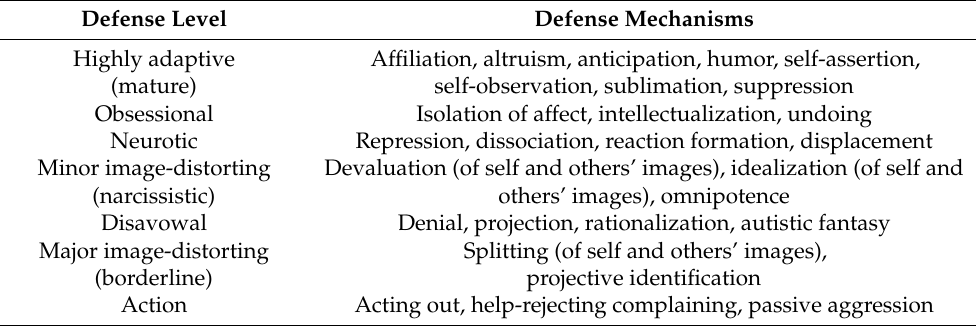
Table 1. Defense levels and their corresponding